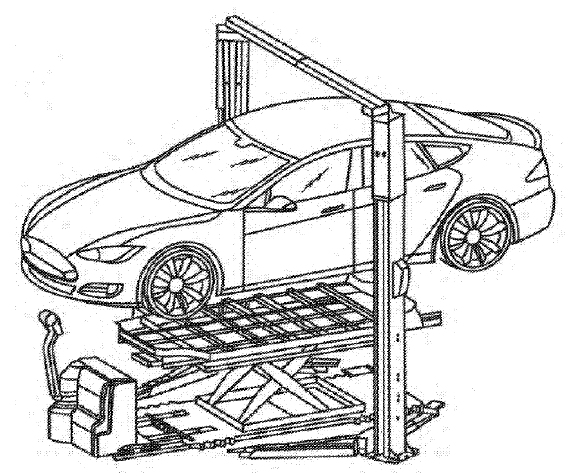
Figure 4. EV raised with the vehicle lift in preparation for a swap [15].